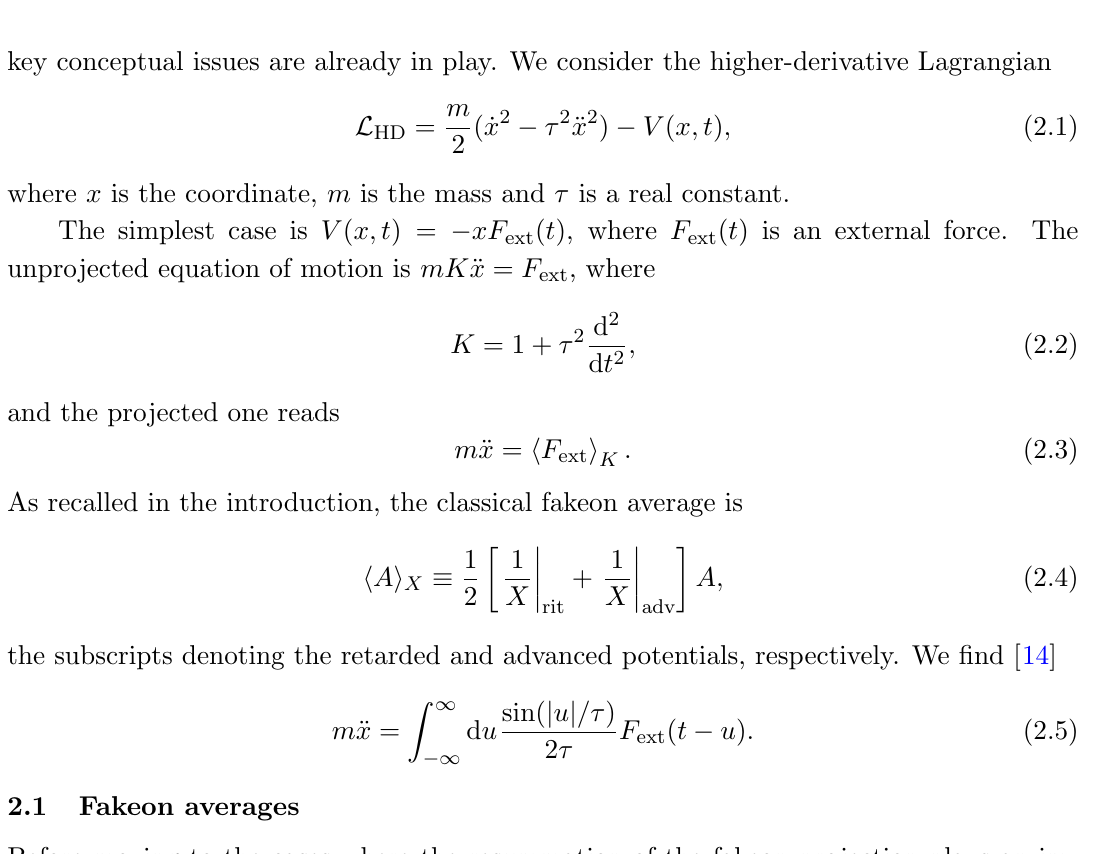
Figure 2 . Fakeon average (continuous line) of a Gaussian function (2.6) (dashed line) with (cid:28) = 1 and (cid:13) = 1 =